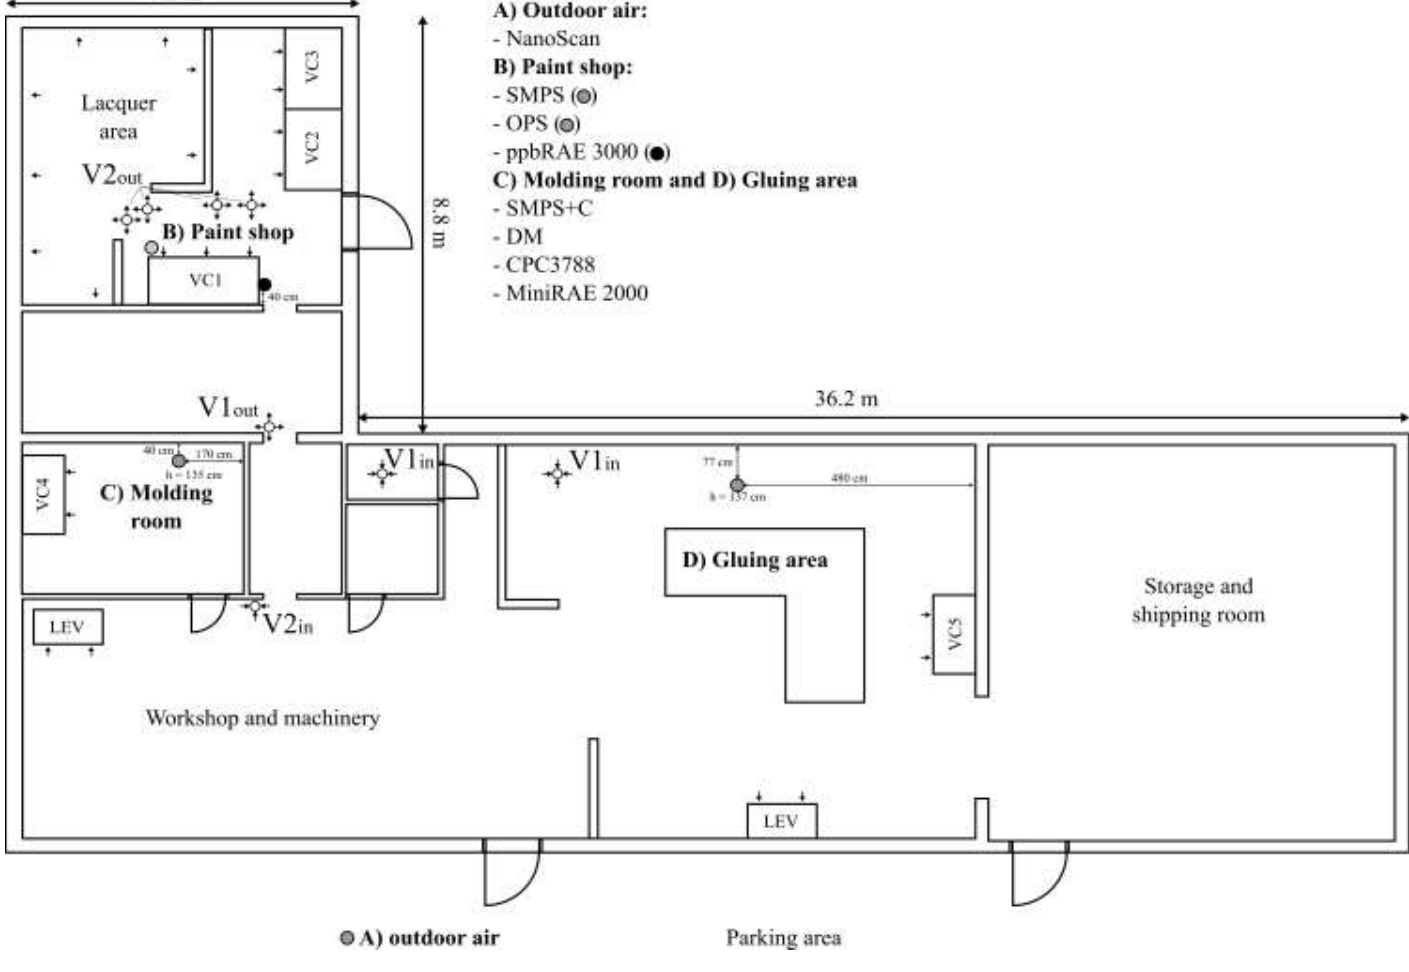
Figure 1. Layout of the workshop. The gray dots and the black dot denote measurement locations. The small arrows denote mechanically induced airflows. LEV and VC are abbreviations for local exhaust ventilation and ventilated cupboard,